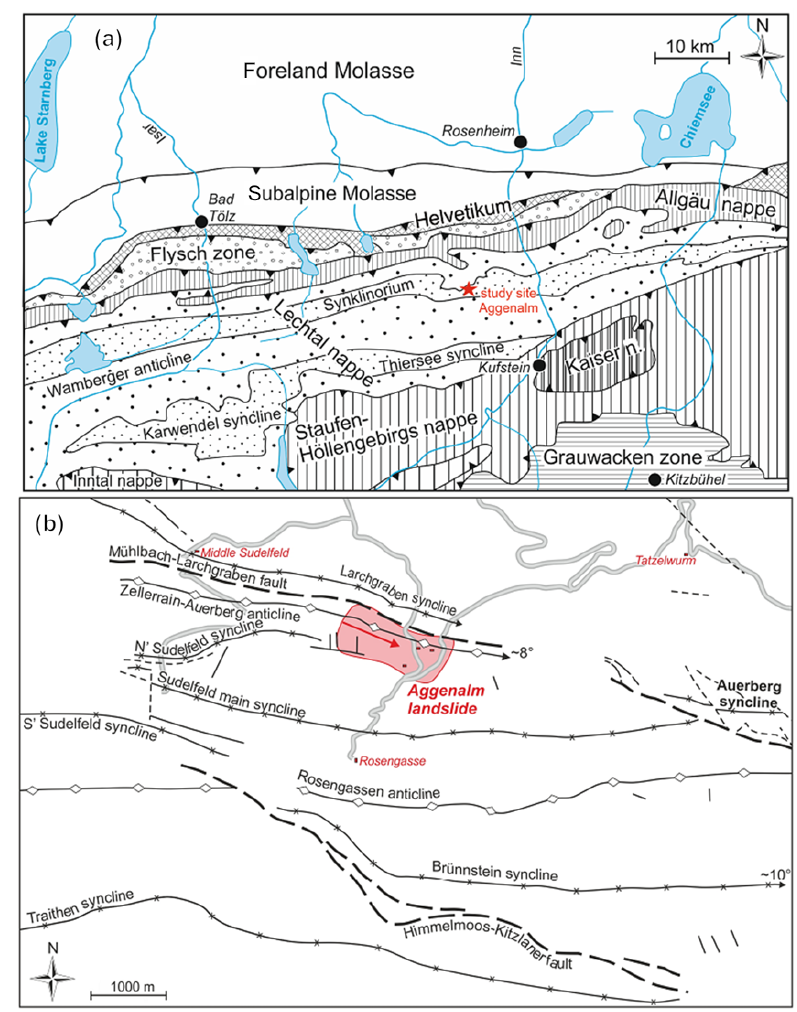
Figure 2. (a) Tectonic map of the Northern Calcareous Alps between Lake Starnberg and Lake Chiemsee. The Aggenalm landslide is situated in the Lechtal Nappe within the Synklinorium, a major syncline–anticline–syncline fold belt, which can be traced through the whole region (Schmidt-thome, 1964; Gwinner, 1971). (b) Detailed tectonic map showing the main tectonic features in the Aggenalm landslide area. Here, the Synklinorium has a complex structure with several additional minor syn- and anticlines, of which the eastward dipping of the Zellerrain–Auerberg anticline is responsible for the nearly slope-parallel orientation of the rock mass within the Aggenalm landslide (Festl,